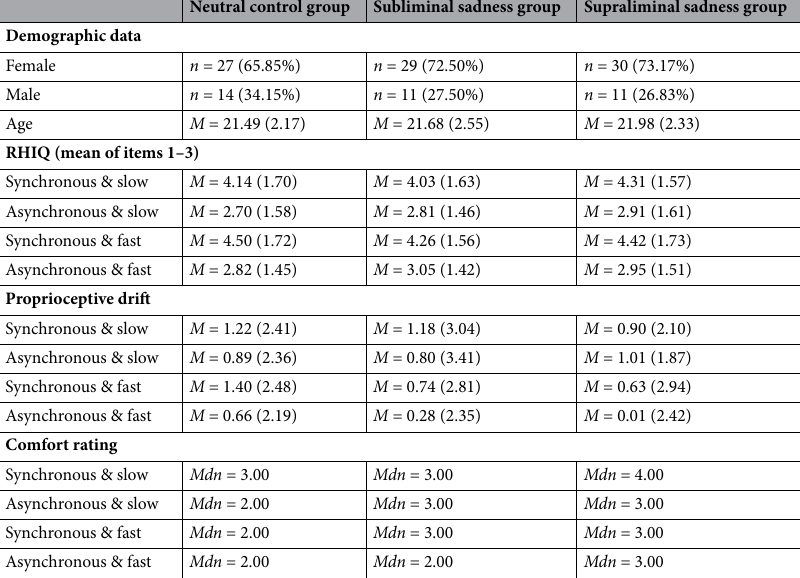
Table 3. Means (standard deviations) / frequencies (relative %) / medians of demographic data and outcome variables.